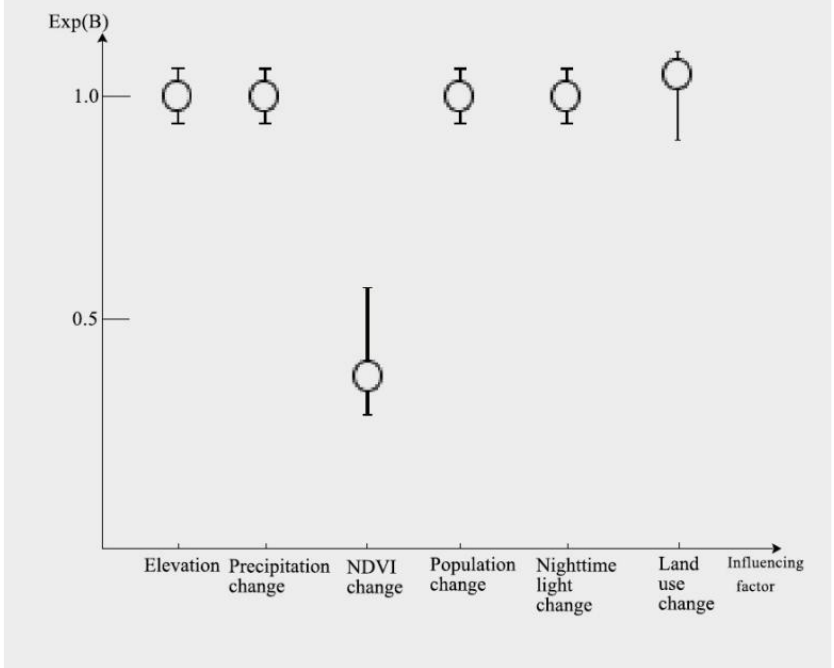
Figure 7. Model estimation of the influencing forces of the changes in habitat quality in Wenzhou City.